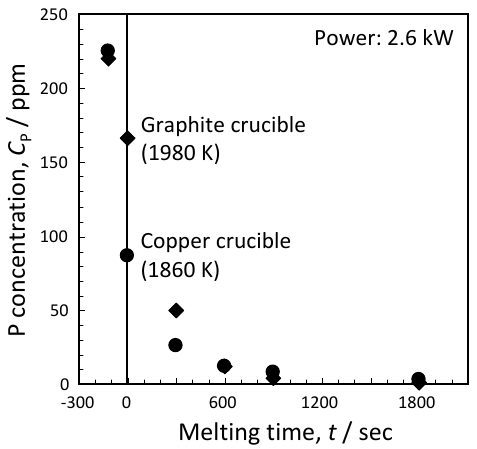
Figure 2. Phosphorus contents as a function of melting time.